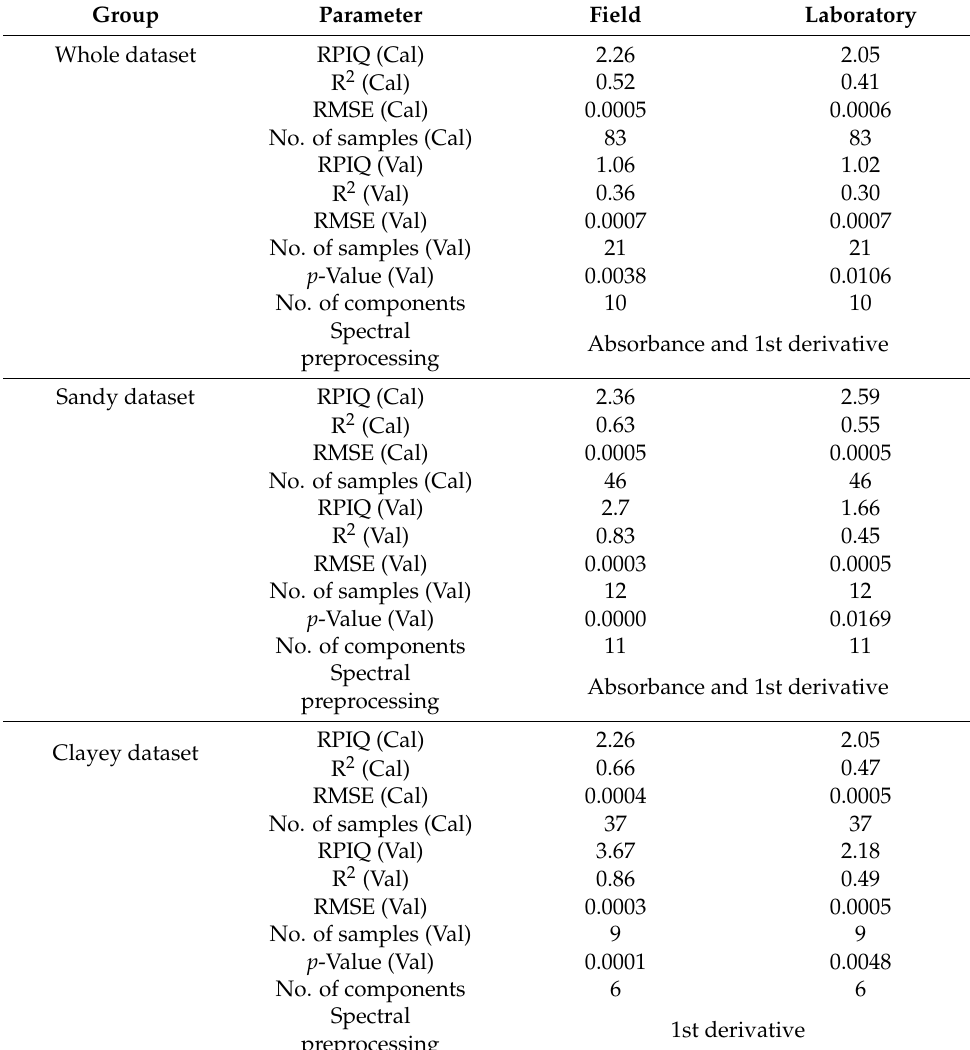
Table 5. Statistical parameters of the spectral-based models after spectral resampling (482–902